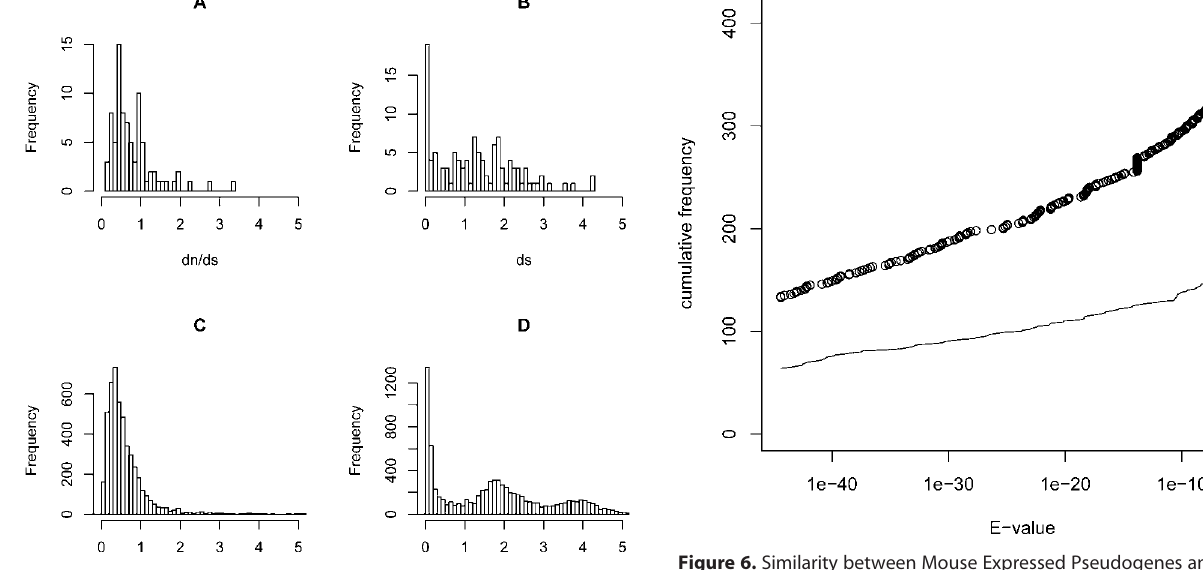
Figure 7. w mRNA Examples (A) Ubiquitin-conjugating enzyme E2D pseudogene and w mRNAs on mouse Chromosome 11. Protein homologies (blue track at top) of human UBE2D and mouse Ube2 paralogues to mouse genomic sequence indicate an unprocessed pseudogene (two frameshifts, see alignment panels, blue gene object). Mouse FANTOM mRNAs (brown tracks, with accession numbers) match genomic sequence without disruption (see alignment panels). No current mouse cDNAs or ESTs support the precise exon structure equivalent to the expressed human UBE2D gene: for example exon three (indicated) is larger than in the human orthologue. FANTOM mRNAs support two splice variants (red gene objects, numbers two and three from top). Two remaining splice variants are based on mouse EST matches (not shown). Pictures are from AceDB F-map (top) and Blixem (alignments, bottom), modified for clarity. (B) Compensatory frameshifts in FANTOM clone E030045F20 (AK053223) (brown track on the right) on mouse Chromosome 11, caused by splice variation in a gene homologous to human C22orf3 at both the 5 9 and 3 9 end of an internal exon on mouse Chromosome 11. The more common